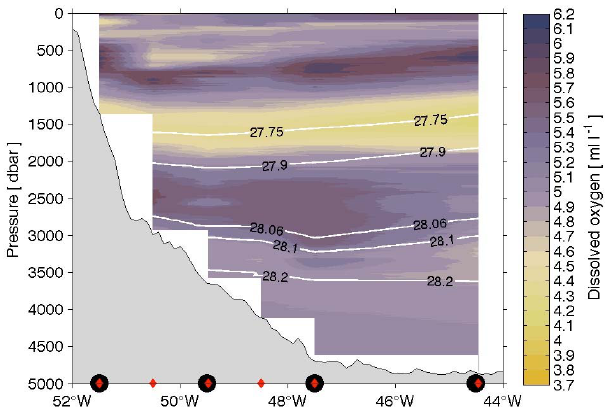
Fig. 4. Dissolved oxygen section collected along the PIES/CPIES Figure 4: Dissolved oxygen section collected along the PIES/CPIES line during July 7- line during 7–11 July 2010 on the Argentine research vessel Puerto 11, 2010 on the Argentine research vessel Puerto Deseado. Red diamonds along bottom Deseado . Red diamonds along bottom axis indicate locations of the axis indicate locations of the CTD profiles, and black dots indicate the PIES/CPIES sites. White contours with labels indicate neutral density surfaces. Bottom topography from the CTD profiles, and black dots indicate the PIES/CPIES sites. White Smith-Sandwell data set (Smith and Sandwell, 1997) is shown in gray. contours with labels indicate neutral density surfaces. Bottom to- pography from the Smith-Sandwell dataset (Smith and Sandwell, 1997) is shown in